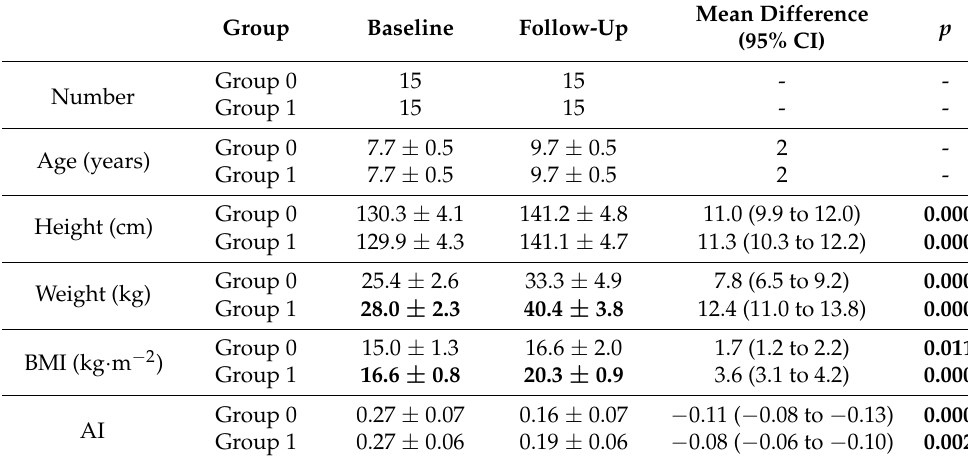
Table 2. Participant characteristics (Mean ± SD). Group